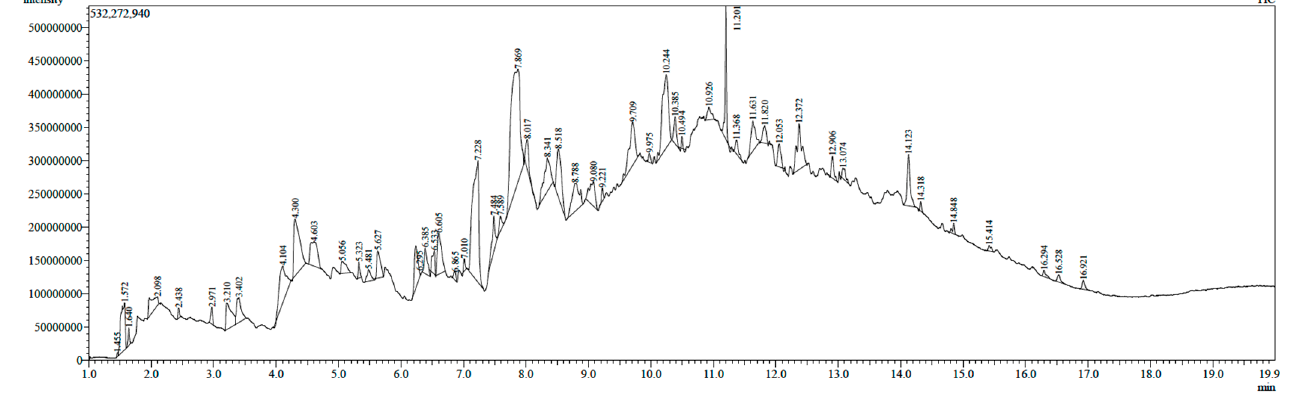
Figure 1. GC–MS chromatogram of the tested manuka honey sample (X-axis: retention time in minutes; Y-axis: intensity). Table 1. Gas chromatography–mass spectrometry analysis of tested manuka honey